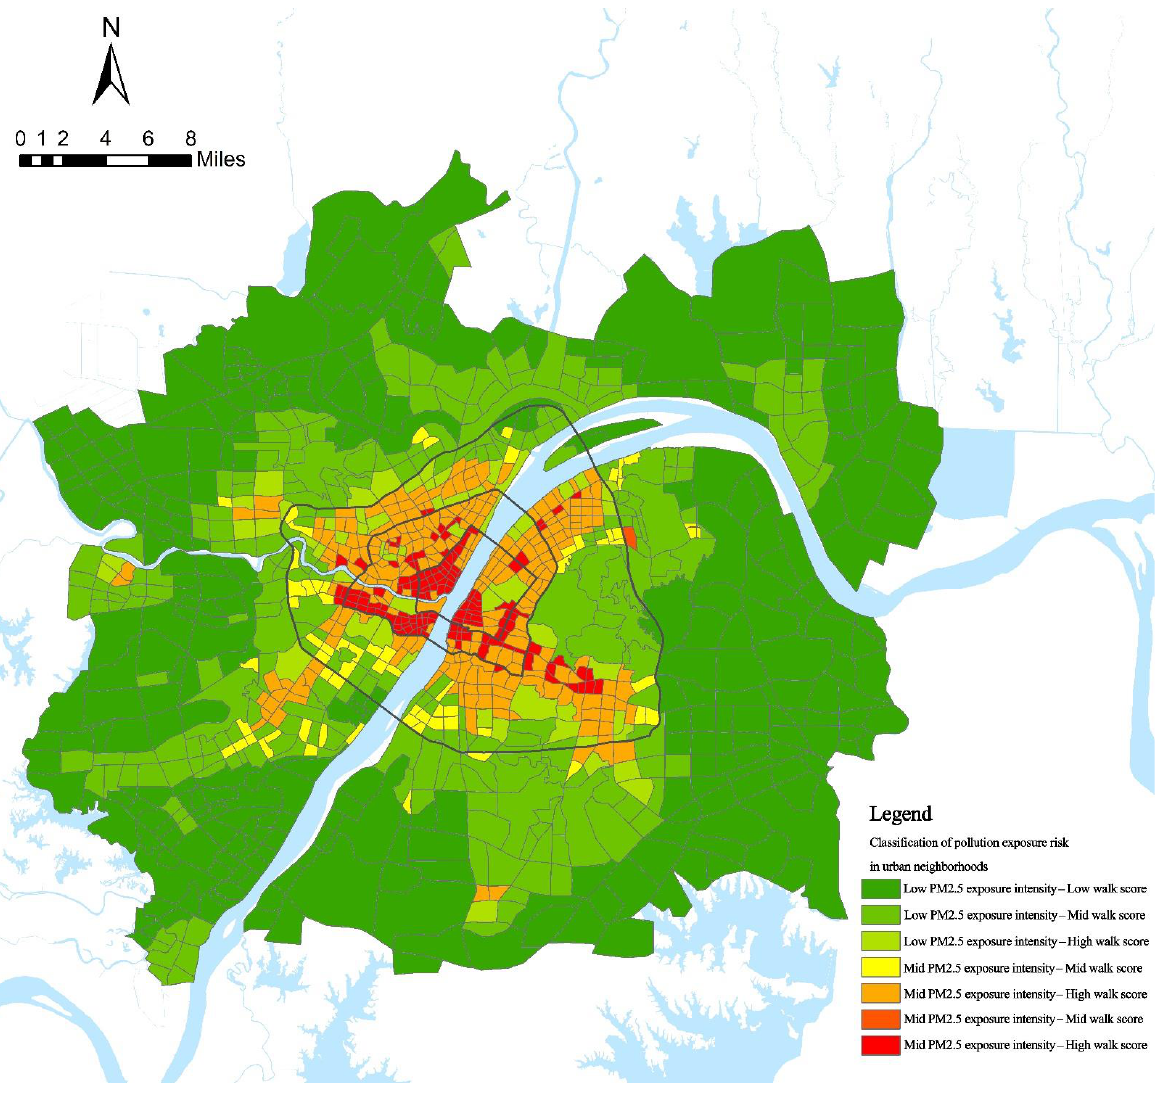
Figure 4. Risk classification of PM 2.5 pollution exposure in urban blocks .